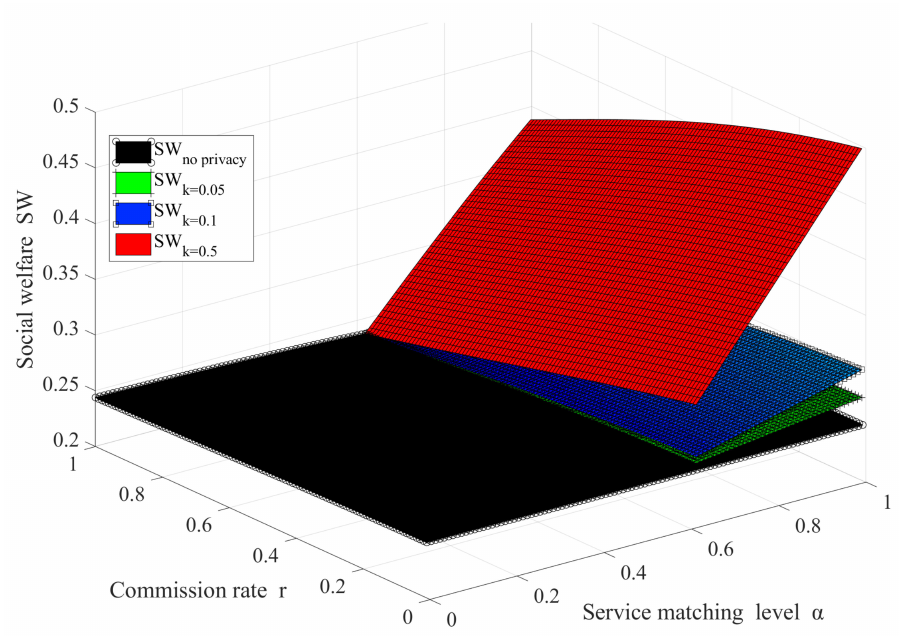
Figure 11. Influence of using consumer data to generate income on social